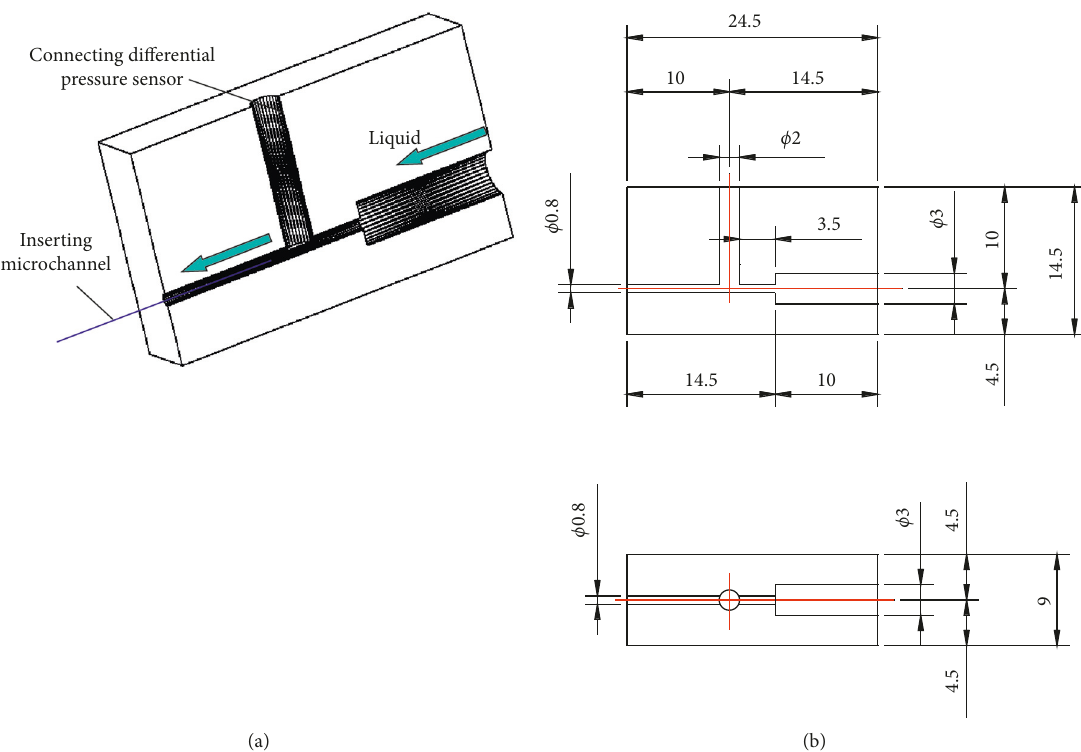
Figure 5: Connection between the differential pressure sensor and microchannel: (a) schematic diagram; (b) size of the connection structure (unit: mm).